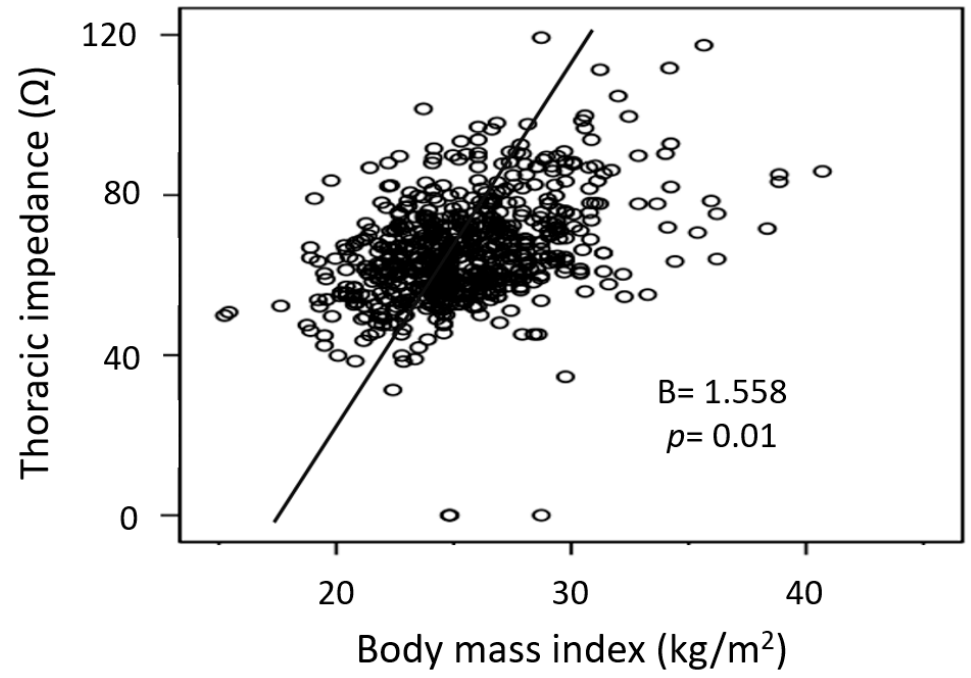
Figure 4. The relationship between human impedance and BMI.